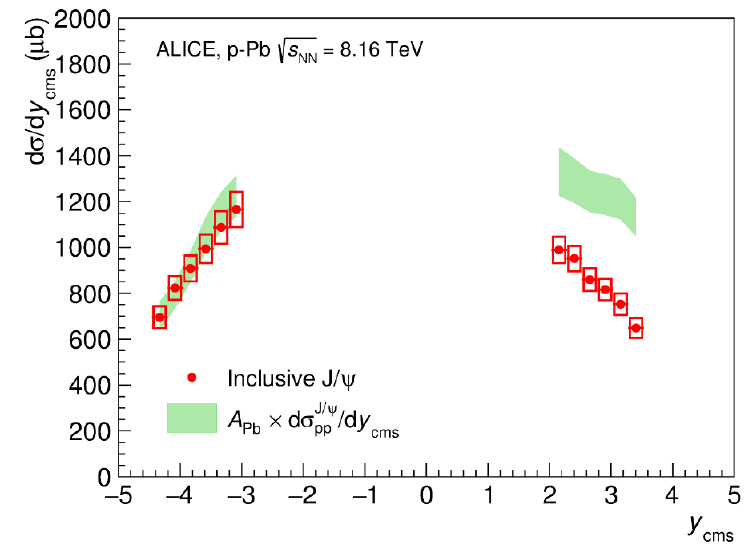
Figure 2 . The y -di(cid:11)erential inclusive J/ production cross section in p{Pb and Pb{p collisions p at s NN = 8 : 16 TeV. The vertical error bars (not visible because smaller than the symbols) represent the statistical uncertainties, the boxes around the points the systematic uncertainties. The horizontal bars correspond to the bin size. The values of the reference pp cross sections, obtained through the interpolation/extrapolation procedure described in section 3, scaled by A Pb , are shown as bands.